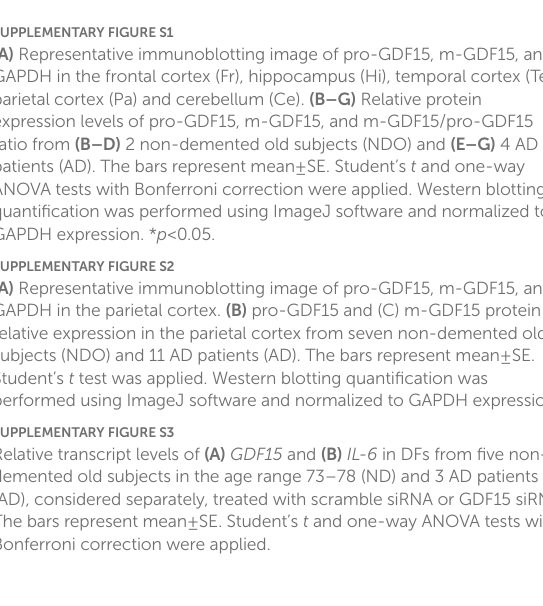
SUPPLEMENTARY FIGURE S1 (A) Representative immunoblotting image of pro-GDF15, m-GDF15, and GAPDH in the frontal cortex (Fr), hippocampus (Hi), temporal cortex (Te), parietal cortex (Pa) and cerebellum (Ce). (B–G) Relative protein expression levels of pro-GDF15, m-GDF15, and m-GDF15/pro-GDF15 ratio from (B–D) 2 non-demented old subjects (NDO) and (E–G) 4 AD patients (AD). The bars represent mean ± SE. Student’s t and one-way ANOVA tests with Bonferroni correction were applied. Western blotting quantification was performed using ImageJ software and normalized to GAPDH expression. * p < 0.05. SUPPLEMENTARY FIGURE S2 (A) Representative immunoblotting image of pro-GDF15, m-GDF15, and GAPDH in the parietal cortex. (B) pro-GDF15 and (C) m-GDF15 protein relative expression in the parietal cortex from seven non-demented old subjects (NDO) and 11 AD patients (AD). The bars represent mean ± SE. Student’s t test was applied. Western blotting quantification was performed using ImageJ software and normalized to GAPDH expression. SUPPLEMENTARY FIGURE S3 Relative transcript levels of (A) GDF15 and (B) IL-6 in DFs from five non- demented old subjects in the age range 73–78 (ND) and 3 AD patients (AD), considered separately, treated with scramble siRNA or GDF15 siRNA. The bars represent mean ± SE. Student’s t and one-way ANOVA tests with Bonferroni correction were